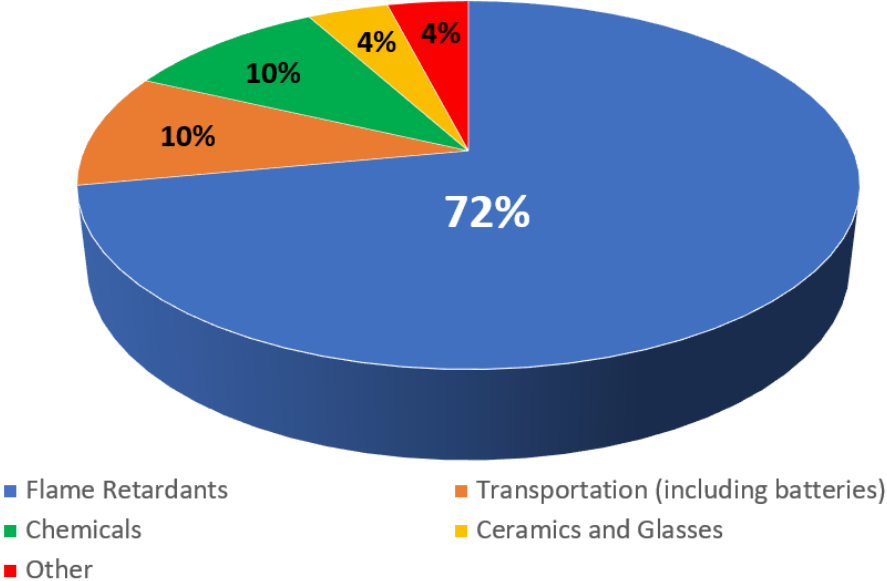
Figure 1 . Major applications of antimony (adapted from [4]). Figure 1. Major applications of antimony (adapted from